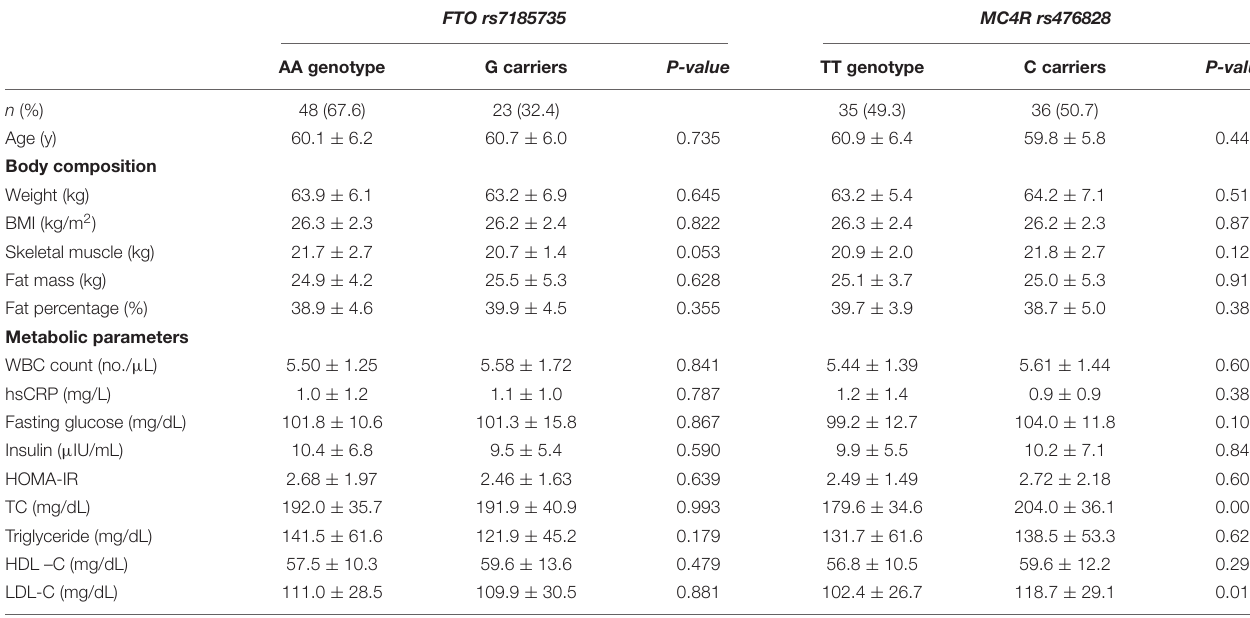
TABLE 1 | Baseline characteristics of study participants according to